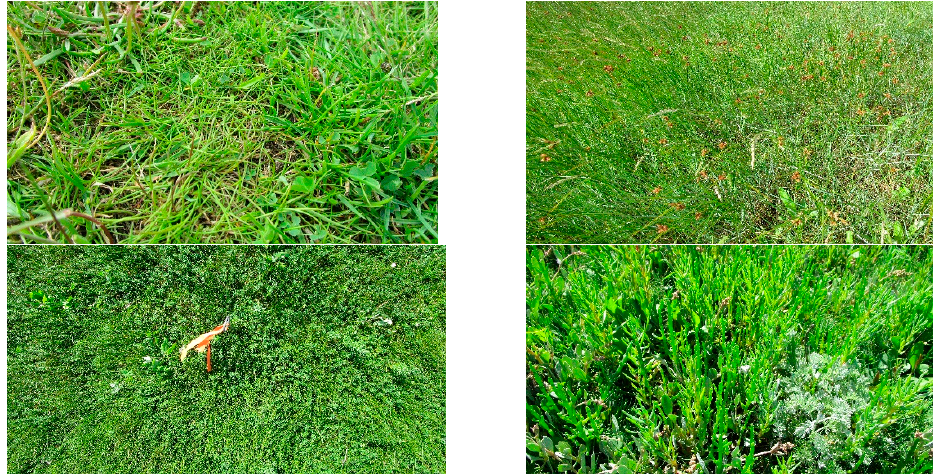
Figure 2. Examples of grass composition observed in the Schiermonnikoog Island, The Netherlands.